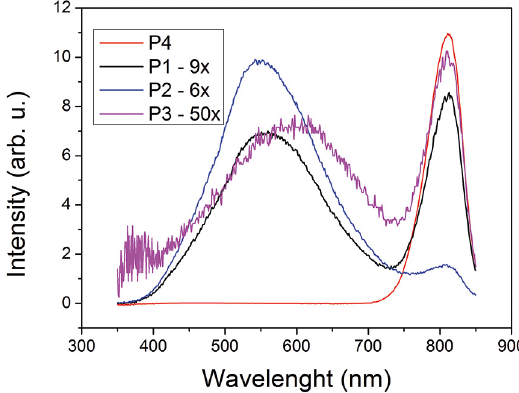
Figure 3. Photoluminescence of pellets P1 to P4. The curves are normalized with respect to intensity. Bands centered at 550 and 800 nm refer to anatase and rutile structures, respectively. Anatase structure is found in three samples with two phases present. Sample P4, with two thermal annealing (before and after pressing) presents only rutile structure.